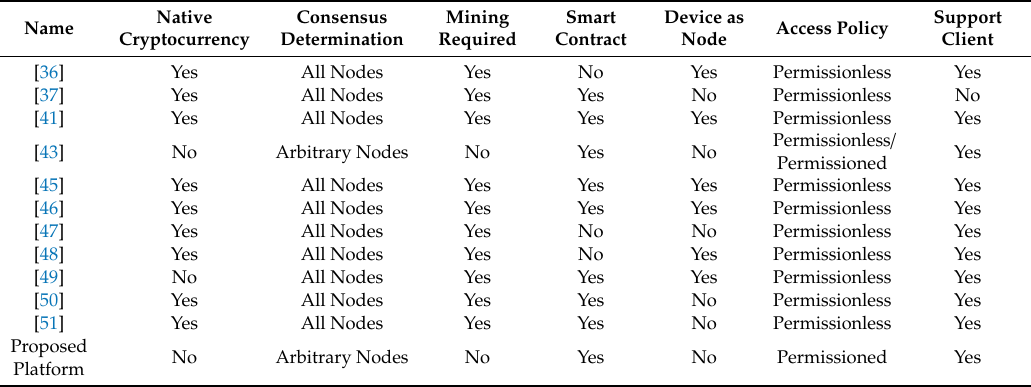
Table 8. Comparative study of the proposed IoT blockchain platform with existing